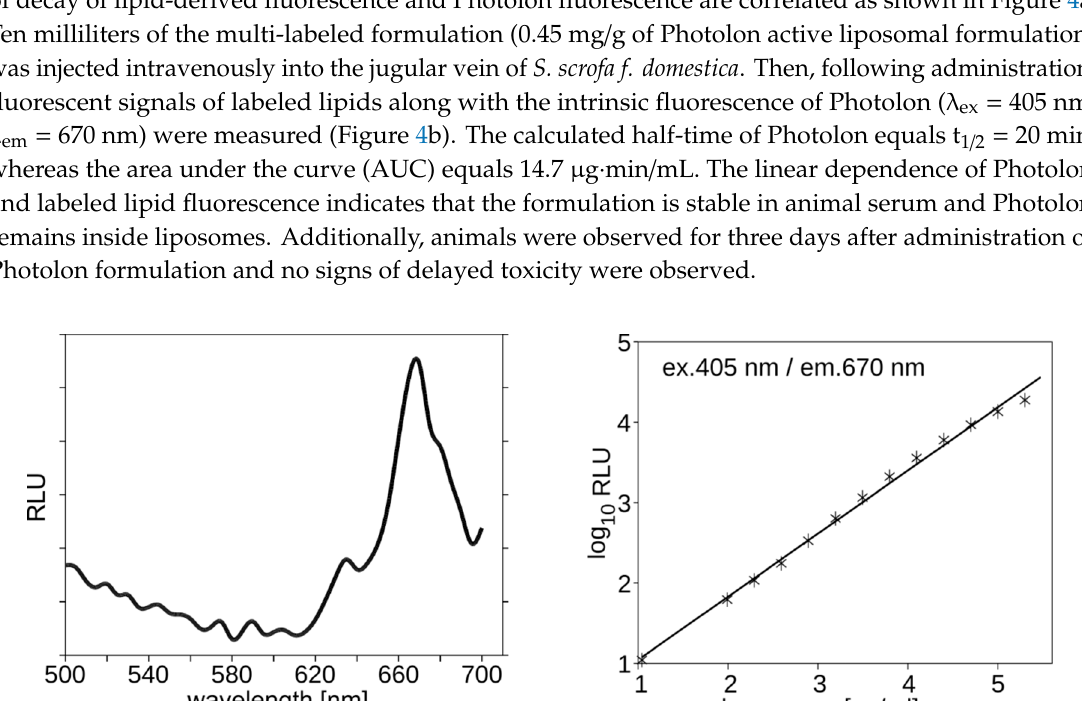
Figure 2. The homogeneity of a population of vesicles encapsulating Photolon. ( a ) Vesicle size distribution obtained from the dynamic light scattering (DLS) experiment; ( b ) quality of the fit of the single population model to an experimentally derived autocorrelation function.